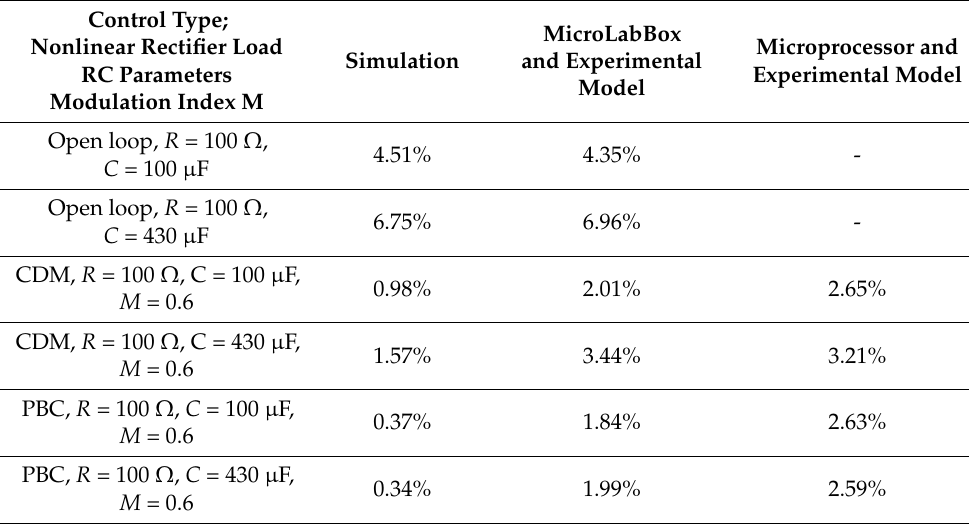
Table 1. Summary of the degree of THD for the Simulink model, real-time MicroLabBox control, and STM32F407VG microprocessor